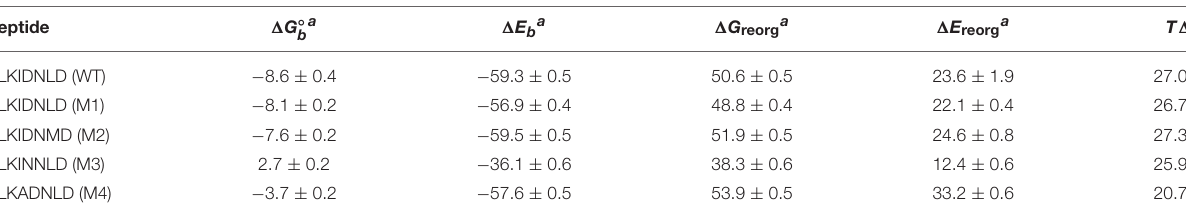
TABLE 1 | Computed thermodynamic parameters for the binding between HIV1-integrase and a series of cyclic peptides derived from the LEDGF protein. Peptide